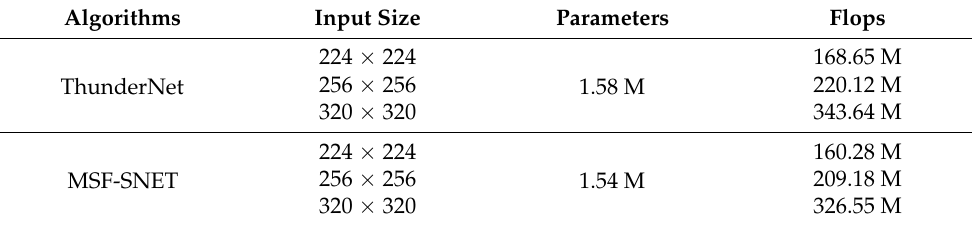
Table 2. Parameters and computing cost for MSF-SNET.